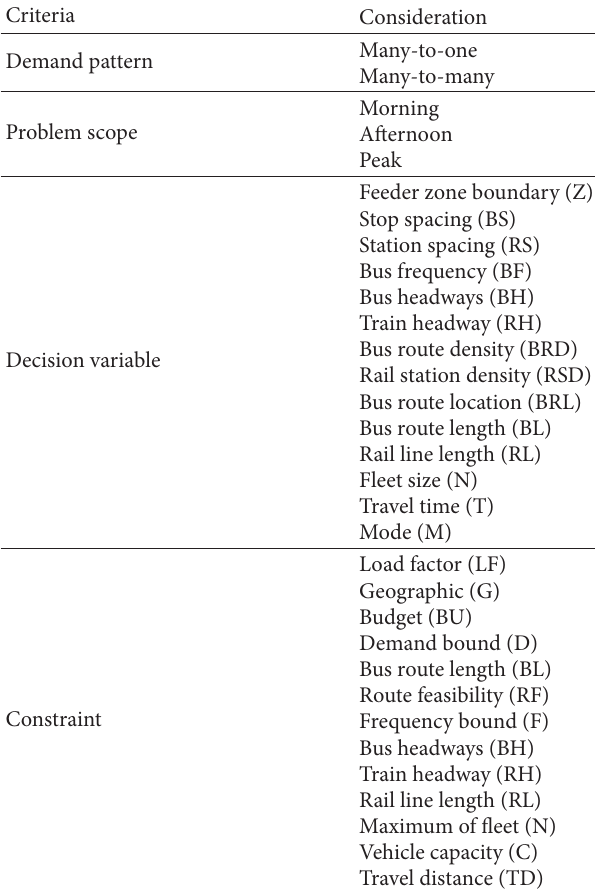
Table 2: Classification criteria from the problem